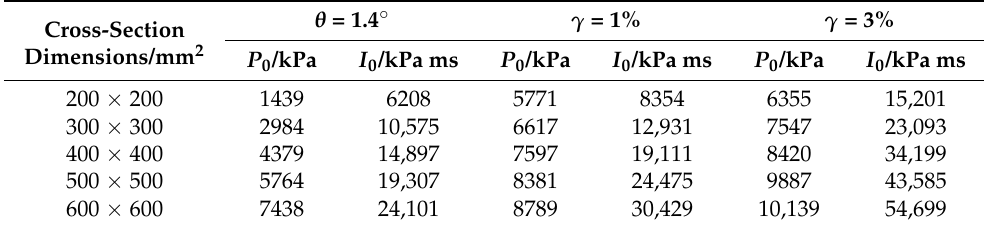
Table 9. Effect of cross-sectional dimension on